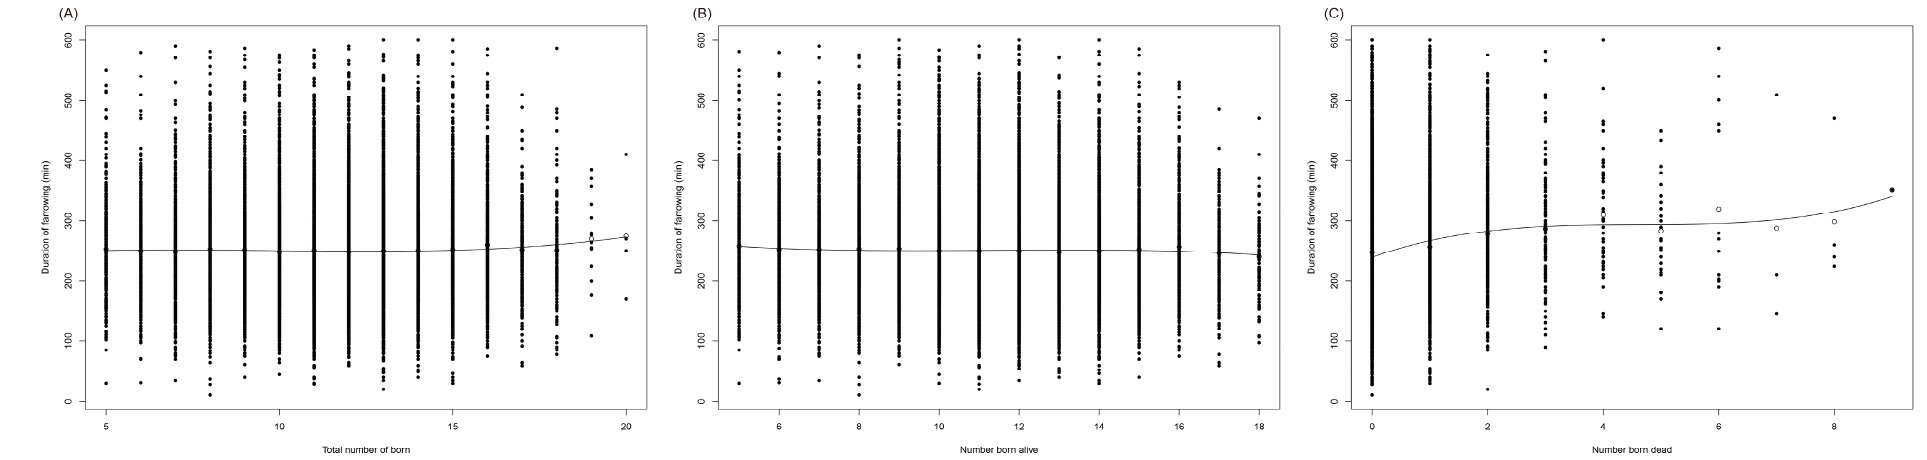
Figure 1. Relation farrowing duration to litter size. Cubic relation between total number of born ( A ), number born alive ( B ), number born dead ( C ) and farrowing duration.